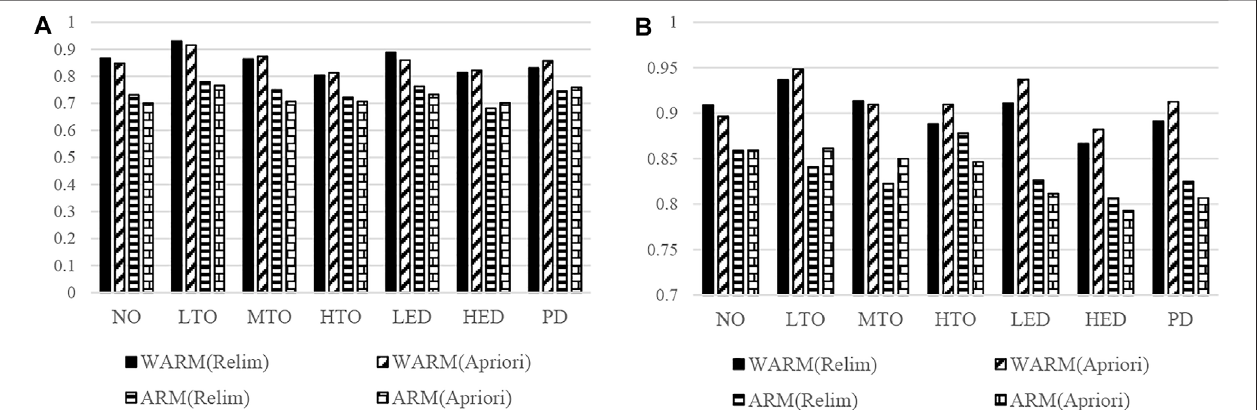
FIGURE 3 | Performance comparison of state case by AUC statistics: (A) ROC, (B) PR.